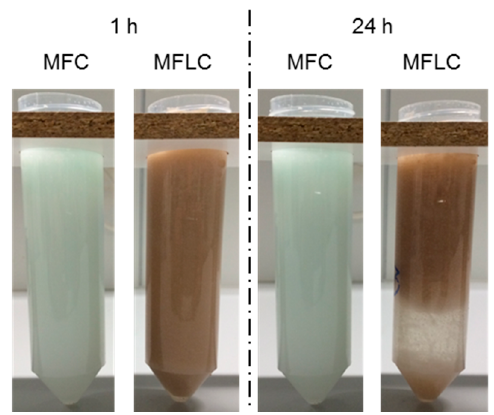
Figure 3. Optical appearance of emulsions of liquid unsaturated polyester resin in water stabilised by 0.5% MFC and MFLC, observed 1 and 24 h after mixing, respectively (tube diameter is 20 mm).